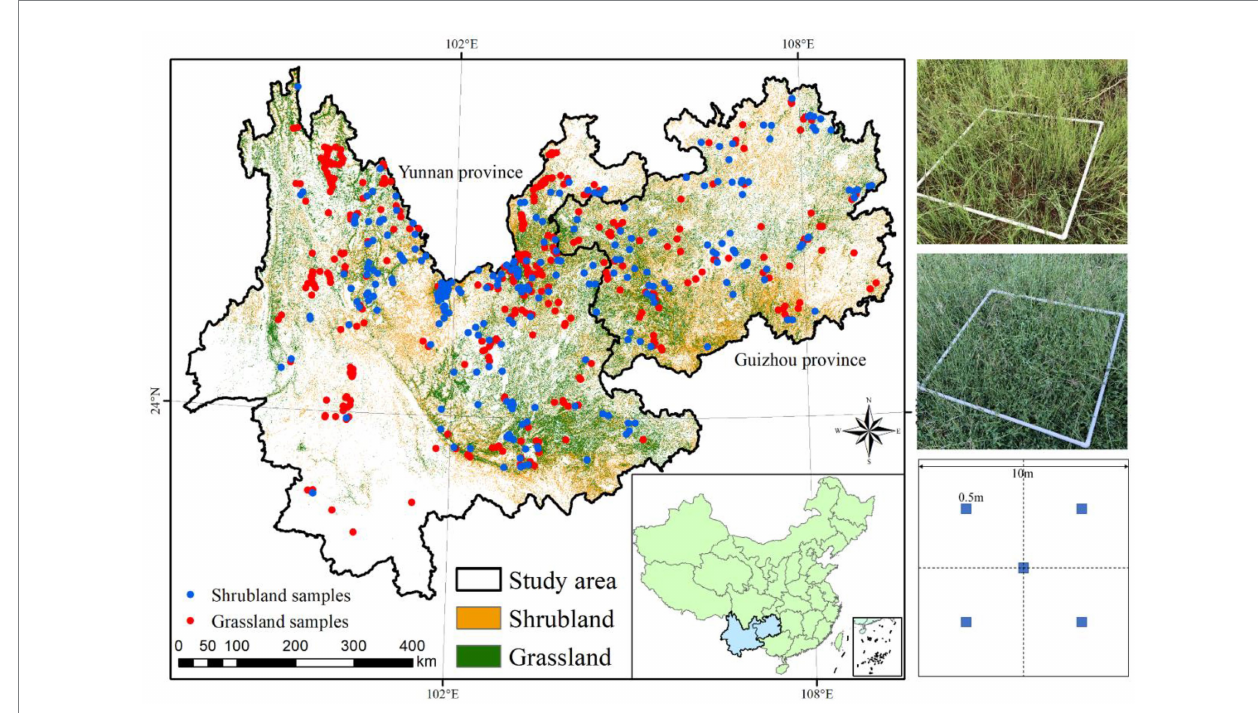
FIGURE 1 The location of the study area and the distribution of shrubland and grassland, as well as field data sample